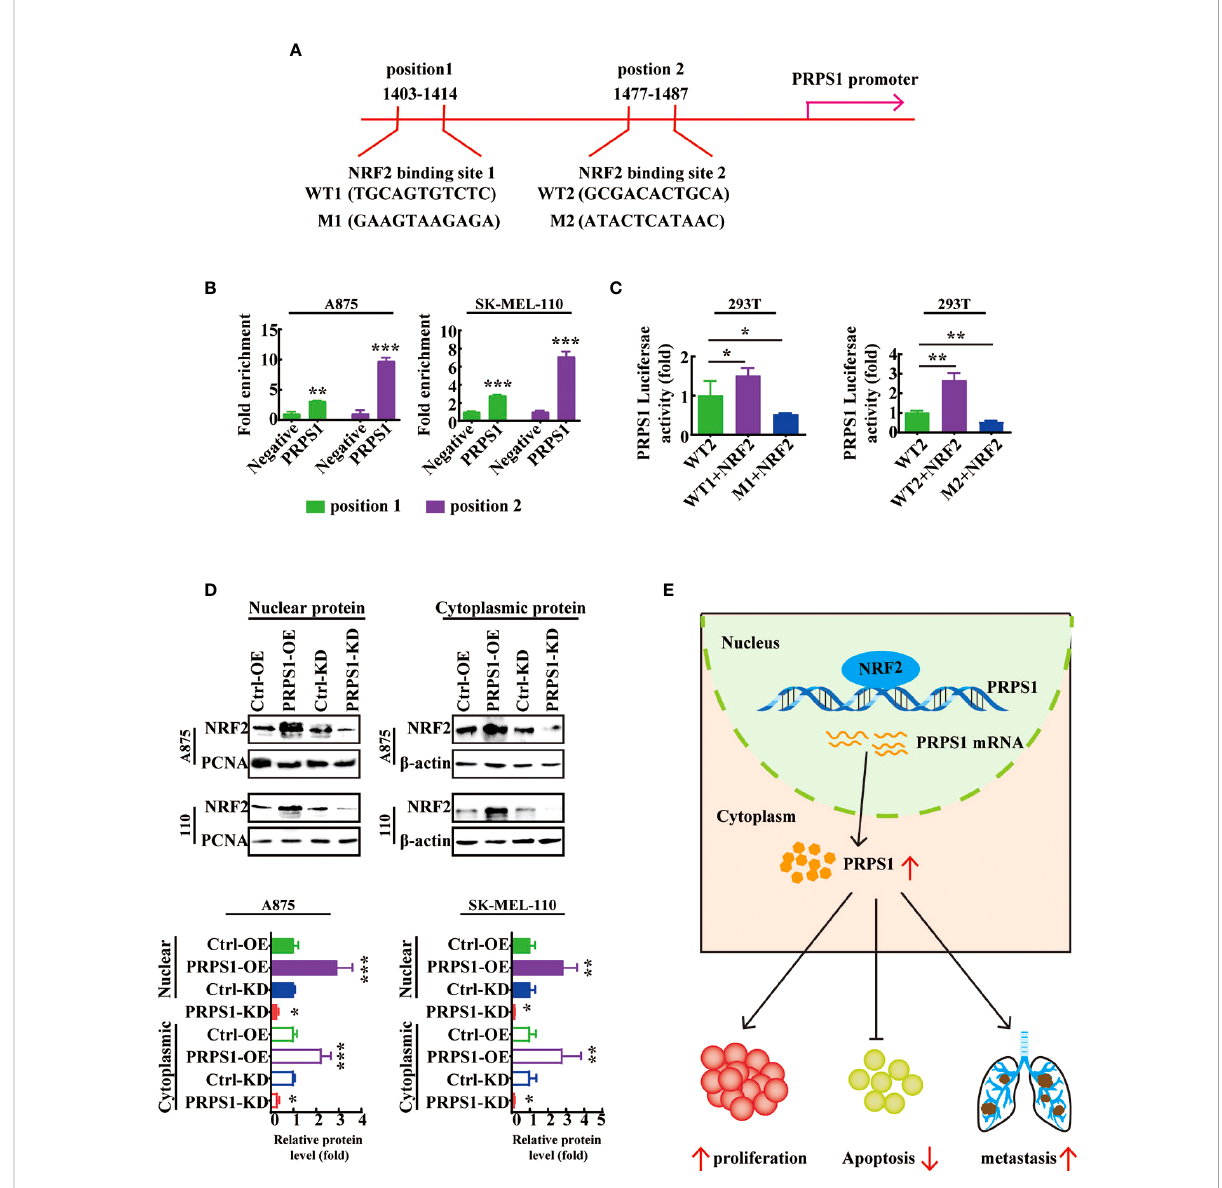
FIGURE 8 NRF2 is a transcription factor of PRPS1-mediated malignant progression of melanoma. (A) Consensus binding sites for NRF2 on the PRPS1 promoter was analyzed by JASPAR database. (B) ChIP assay was performed to assess NRF2 in the PRPS1 promoter region in A875 and SK-MEL- 110 cells. (C) 293T cells were transfected with corresponding plasmids for 48h. Luciferase dual reporter assays were performed to measure the luciferase activity of PRPS1-luc. (D) NRF2 expression in nuclei and cytoplasm of A875 and SK-MEL-110 cells overexpressing or knockdown PRPS1. (E) Proposed model of the relationship between PRPS1 and NRF2 in melanoma cells. The data represent three independent experiments. The data represent three independent experiments. Each bar represents mean ± SD. p values were calculated using a student t-test (* p < 0.05, ** p < 0.01, ***p < 0.001 vs. the